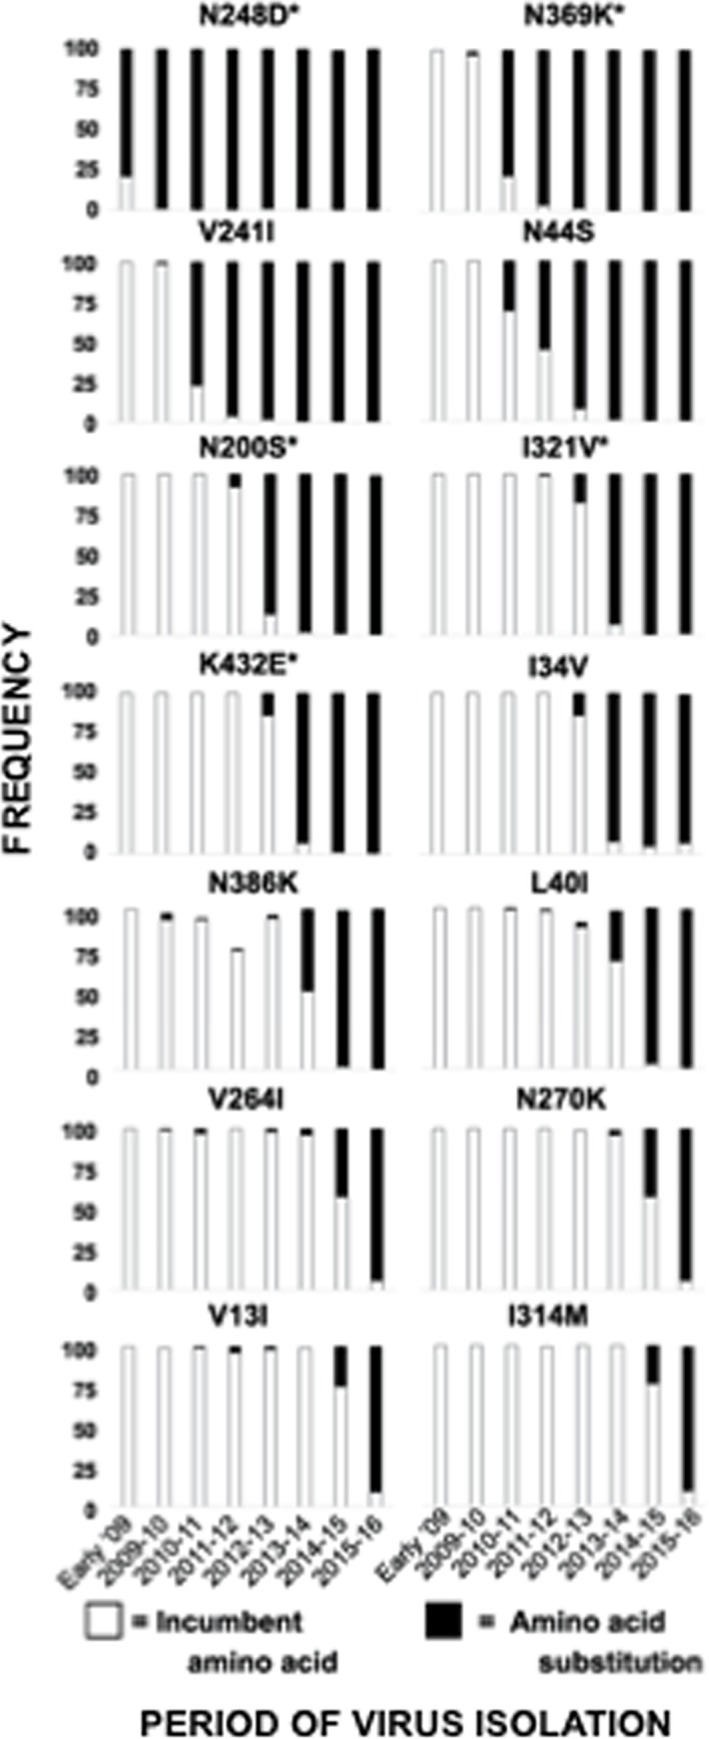
Frequency of NA amino acid changes found in pH1N1-like viruses over time.Publicly available sequences of the NA protein of pH1N1-like strains isolated since 2009 (n = 15,805) were analyzed, and were plotted according to the percentage of sequences containing the original (incumbent) amino acid present in the H1N1 vaccine strain (white) or the substitute amino acid (black) in pH1N1-like isolates at positions 13, 34, 40, 44, 200, 241, 248, 264, 270, 314, 321, 369, 386, and 432 from each season since early 2009. An (*) next to the amino acid location indicates that the position is in a previously described antigenic site.